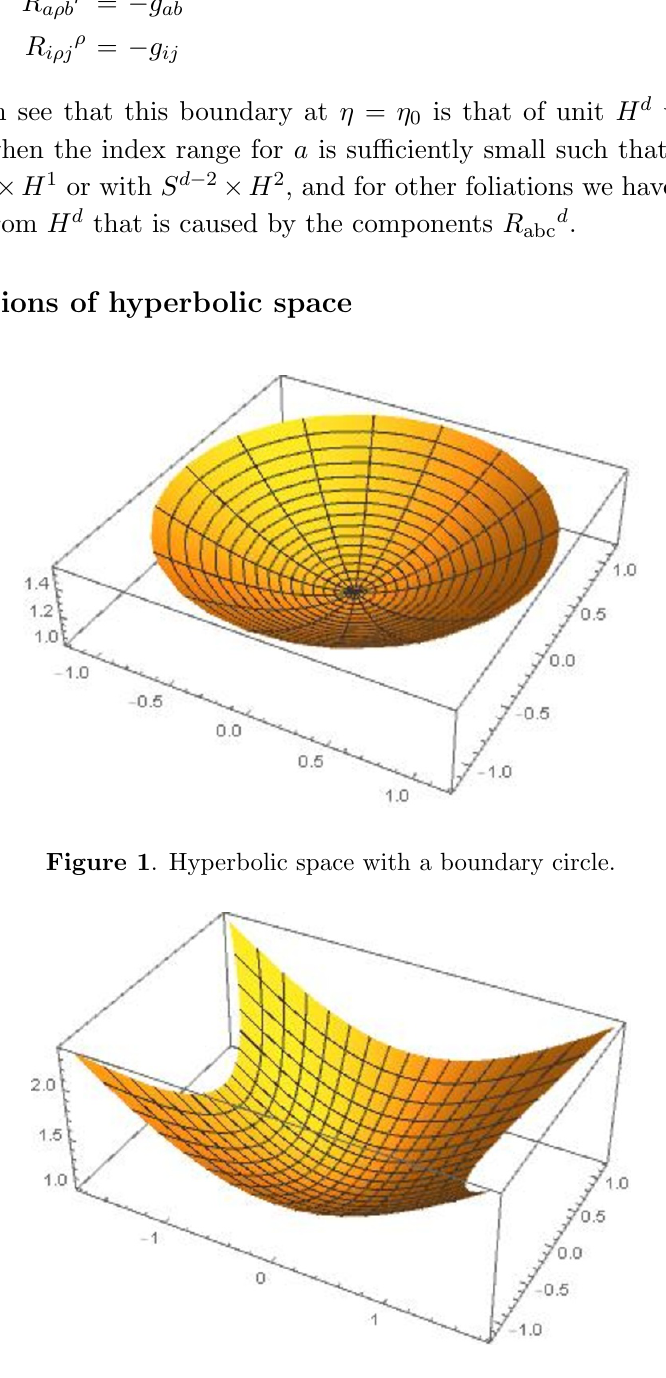
Figure 2 . Hyperbolic space with a boundary with four corners.